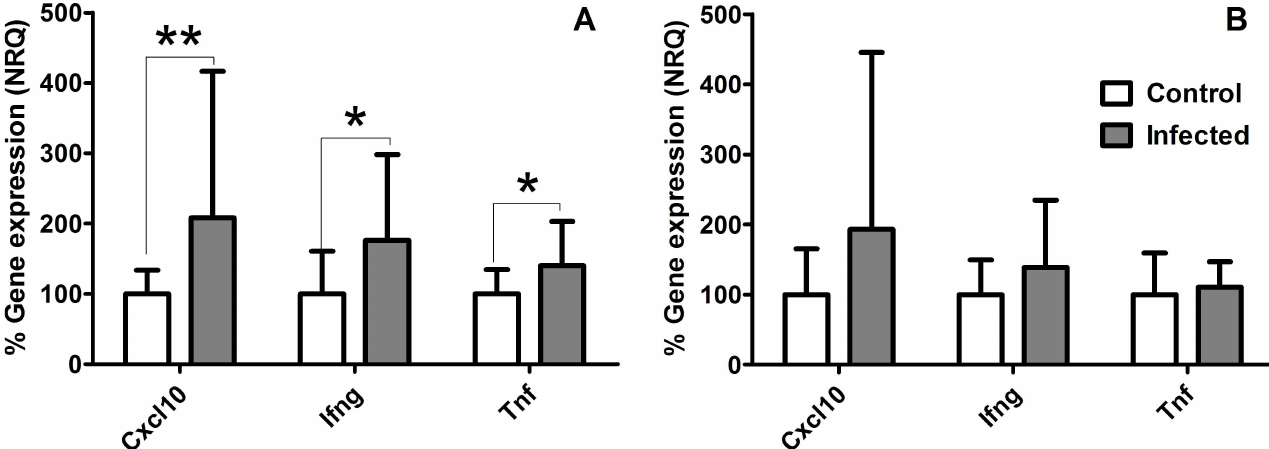
Fig 4. Relativegeneexpression of Cxcl10 , Ifng and Tnf afternormalization with Igtb2 + Il2rg (A) or Tbp + Polr2a (B). Mann-Whitney test was used to calculatedifferences in normalisedrelative gene expression (NRQ)of Leishmania -infectedvs control BALB/c mice (expressed as percentage). ** p < 0.01; * p < 0.5. The uncertaintyvalues were as follows: Cxcl10, Igtb2 + Il2rg normalization: control mice = 1.03;infected mice = 0.52; Tbp + Polr2a normalization: controlmice = 0.82; infected mice = 0.24.Ifng, Igtb2 + Il2rg normalization: controlmice = 0.50;infected mice = -0.09; Tbp + Polr2a normalization: controlmice = 0.38;infected mice = 0.09.Tnf, Igtb2 + Il2rg normalization: controlmice = 0.93;infected mice = 0.37; Tbp + Polr2a normalization: controlmice = 0.78; infected mice =